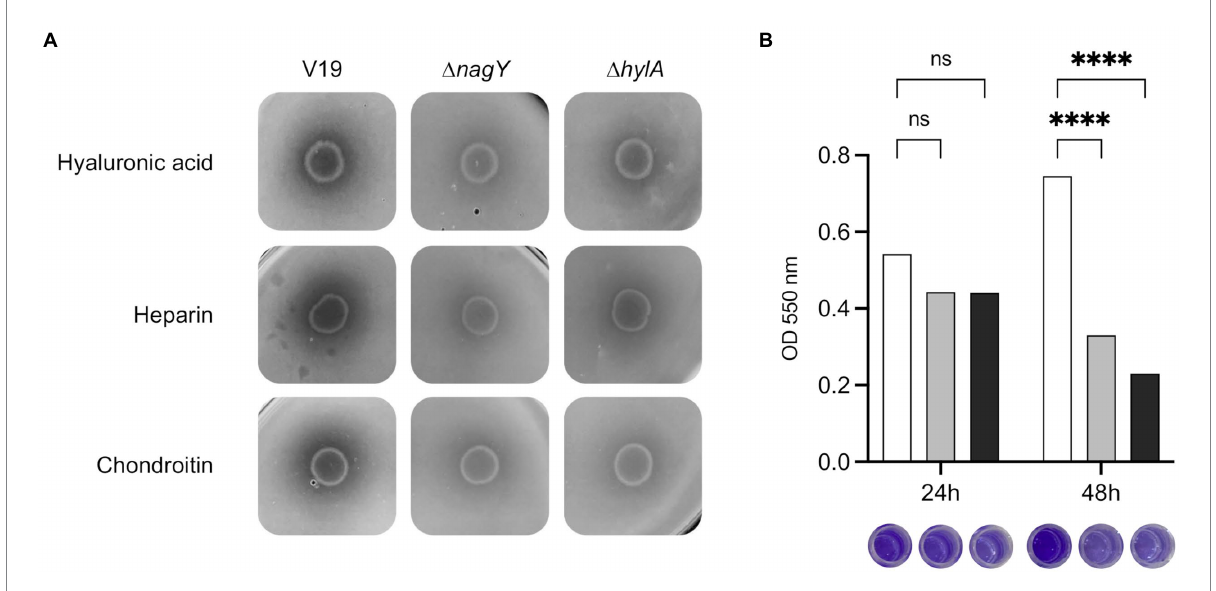
FIGURE 8 Involvement of NagY and HylA in GAG degradation and biofilm formation. (A) Degradation of GAGs (hyaluronic acid, heparin sodium, or chondroitin sulfate) by Enterococcus faecalis V19 WT, Δ nagY , and Δ hylA was studied after cells grown on GAG minimal plate with BSA and revealed by the addition of 2 M acetic acid, as described in the Materials and methods section. Halo formation is proportional to GAGs degradation. (B) Study of biofilm formation in WT (white), Δ nagY (gray) and Δ hylA (black) strains with the corresponding observation of crystal violet staining.